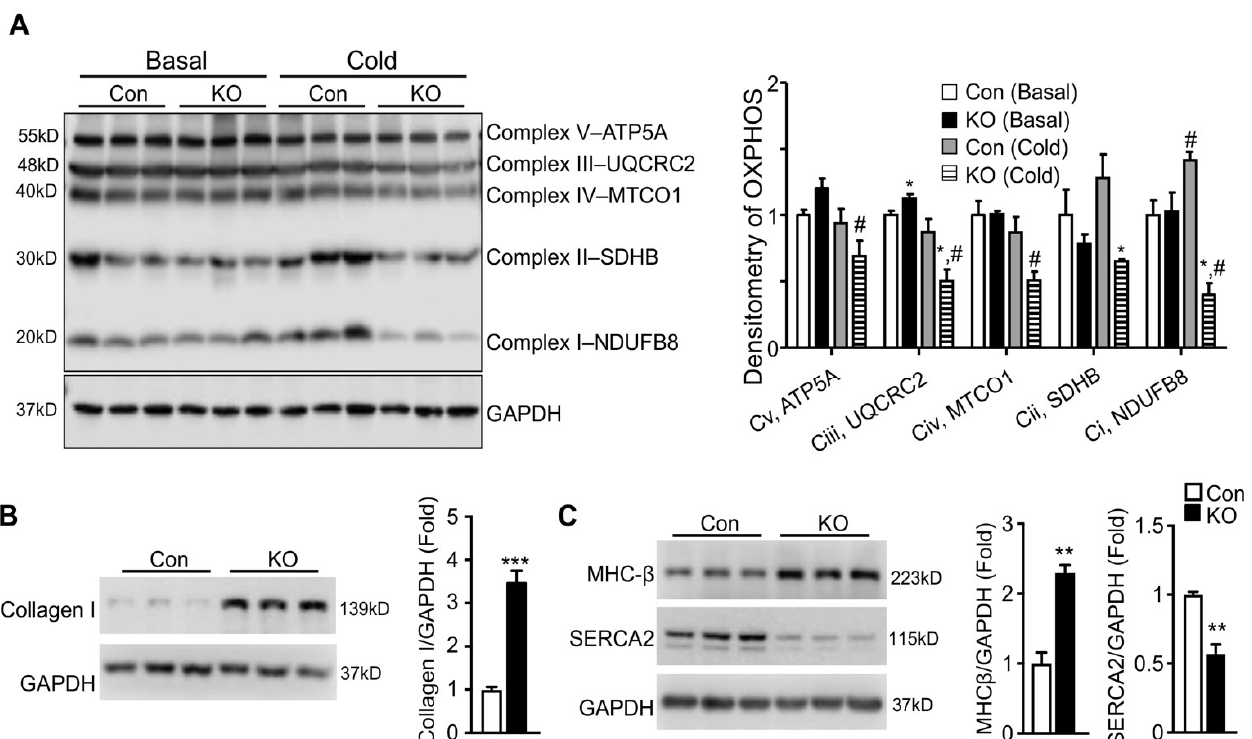
Figure 5. Deletion of adipose CGI-58 induces pathological remodeling of the heart. ( A ) Western blots and densitometry analysis of mitochondrial electron transport chain complex proteins in the hearts of 10–12-week-old chow-fed mice with or without cold exposure for seven days. ( B , C ) Western blots and densitometry analysis of biomarkers for pathological remodeling in the hearts of the mice described under Figure 4. * p < 0.05, ** p < 0.01, *** p < 0.001 vs. genotype; # p < 0.05 vs. housing temperature by two-tailed unpaired Student’s t -test. MTCO1, mitochondrially encoded cytochrome C oxidase 1; NDUFB8, NADH:ubiquinone oxidoreductase subunit B8; SDHB, succinate dehydrogenase complex iron sulfur subunit B (SDHB), UQCRC2, ubiquinol-cytochrome C reductase core protein 2.